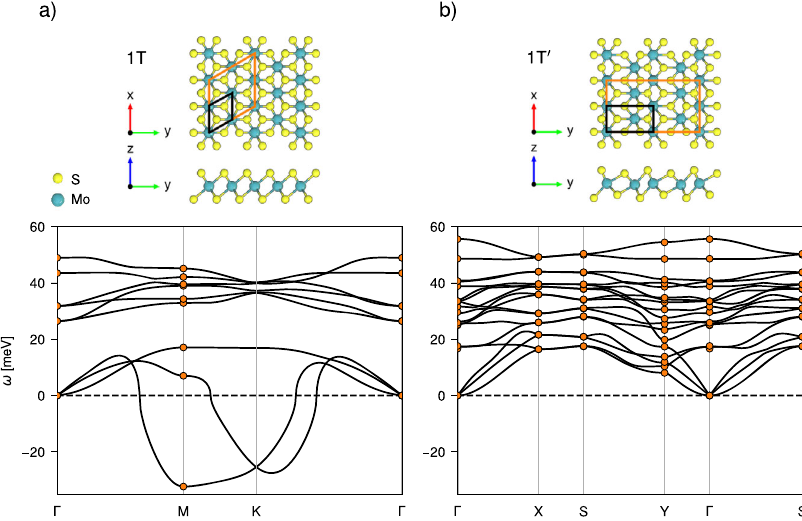
Fig. 3 Phonons frequencies of the T and T ’ phase of MoS 2 . The CBP protocol captures the instability of the T-phase ( a ) of MoS 2 . Both the primitive unit cell (black) and the 2 × 2 supercell (orange) are shown. Displacing the atoms along the unstable TA mode at the M-point ( q ¼ ð 1 which can be accommodated in the 2 × 1 supercell, and subsequently relaxing the structure results in the dynamically stable T'-phase ( b ).